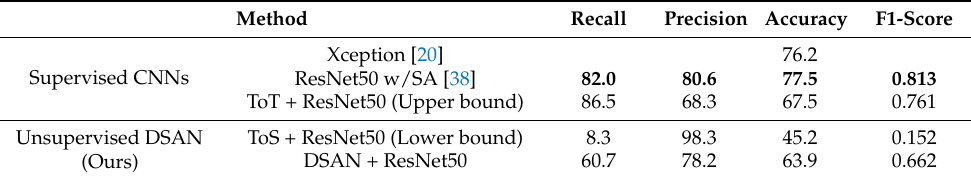
Table 4. Quantitative results of supervised CNNs and DSAN on the testing set of